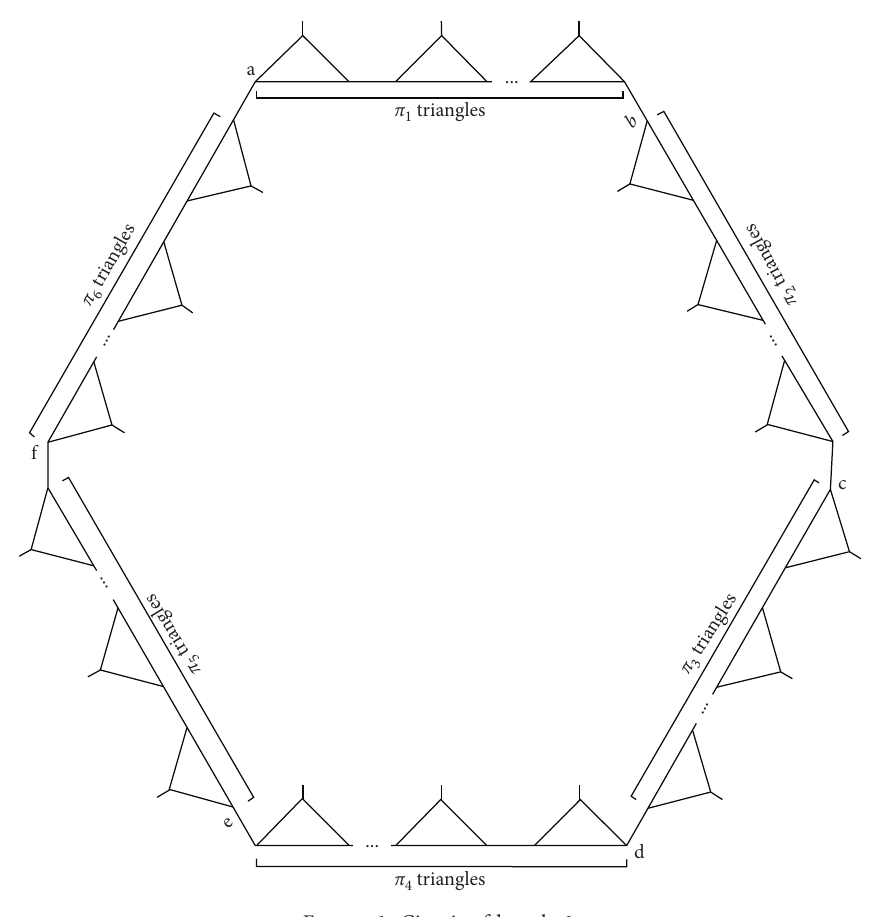
Figure 1: Circuit of